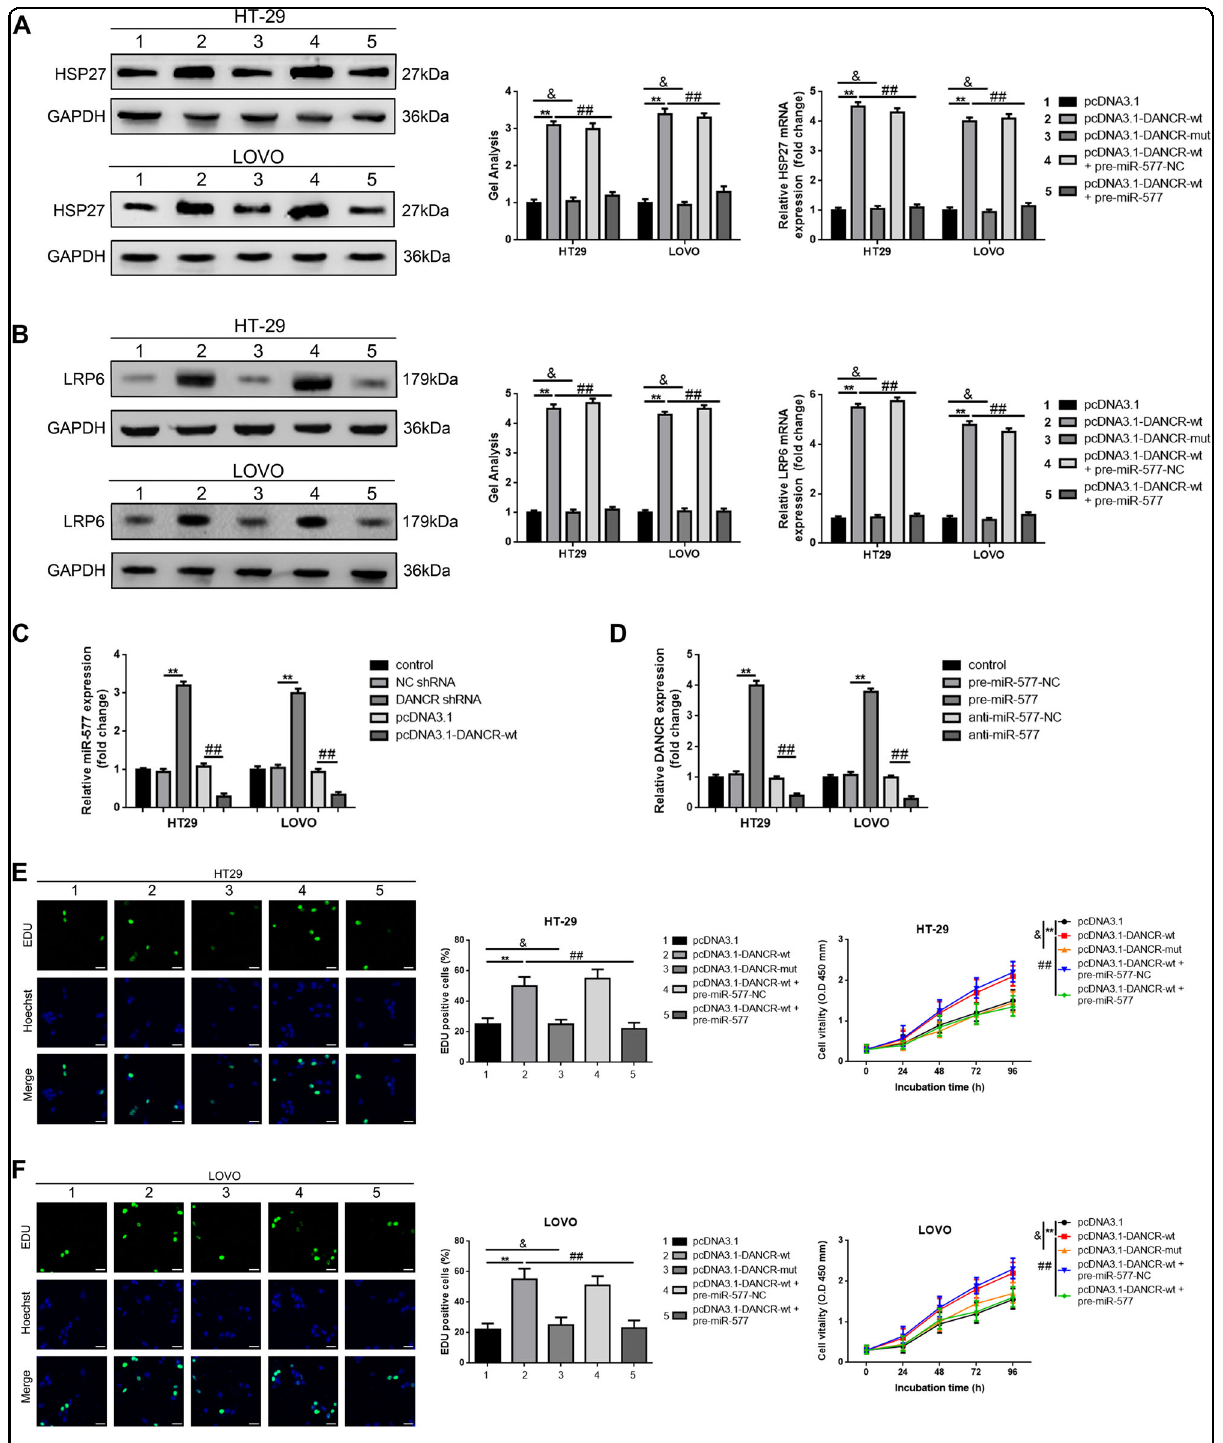
Fig. 6(See legend on next